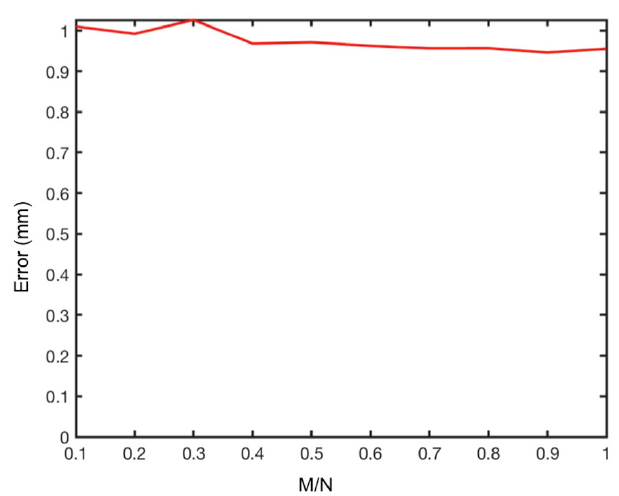
Figure 11. Displacement error in function of M/N for a stable point in the test site “Campus”.